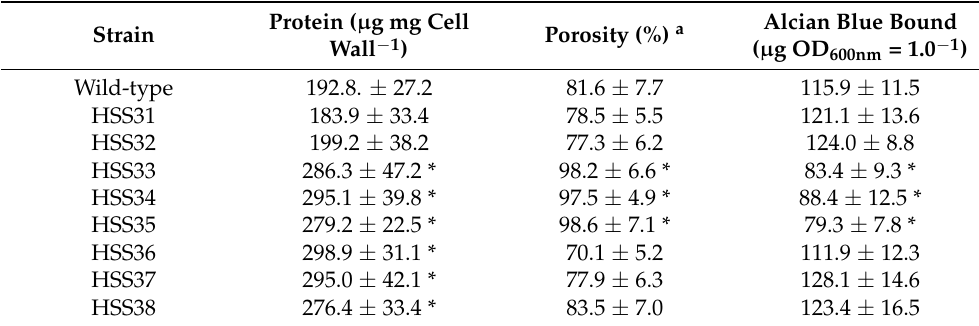
Figure 4. Cell wall analysis of Sporothrix schenckii wild-type, control, and ROT2 -silenced mutant strains. In ( A ), the cell wall was isolated from yeast-like cells and acid hydrolyzed, and monosaccharides were identified and quantified by high-performance anion-exchange chromatography with pulsed amperometric detection. In ( B ), yeast-like cells were incubated with either fluorescein isothiocyanate (FITC) conjugated wheat germ agglutinin or IgG Fc-Dectin-1 chimera and anti-Fc IgG-FITC for chitin or β -1,3-glucan labeling, respectively, and the fluorescence associated to 300 cells was estimated. Data were normalized to the fluorescence observed in heat-killed cells, which corresponds to 100% in both cases. Data are represented as mean ± SD of three independent experiments performed in duplicates. * p < 0.05 when compared to WT, HSS31, or HSS32 cells. Table 2. Cell wall protein content, porosity, and ability to bind Alcian blue of Sporothrix schenckii wild-type, control, and ROT2- silenced strains.